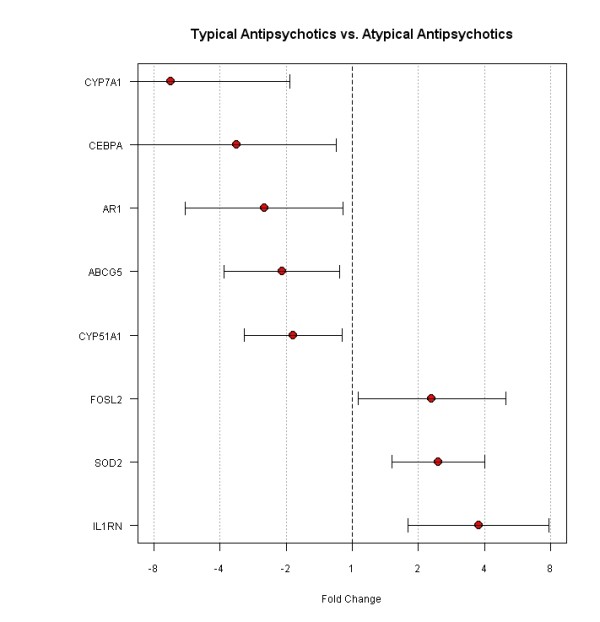
The qPCR validation of genes differentially expressed between the typical AP group and the atypical AP group based on the microarray data analysis. Normalized values for each gene in the typical AP group were expressed as fold change as compared to the atypical AP group. Each gene is shown with fold change and 95% confidence intervals.